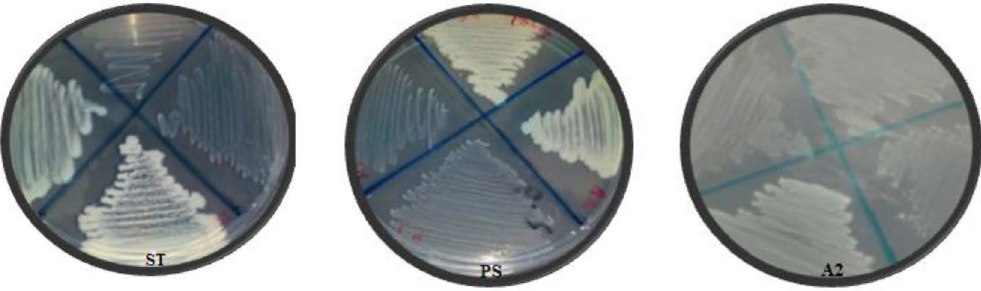
Fig. 5. Growth of ST, A2 and PS on agar plate contain different of concentrations CdCl